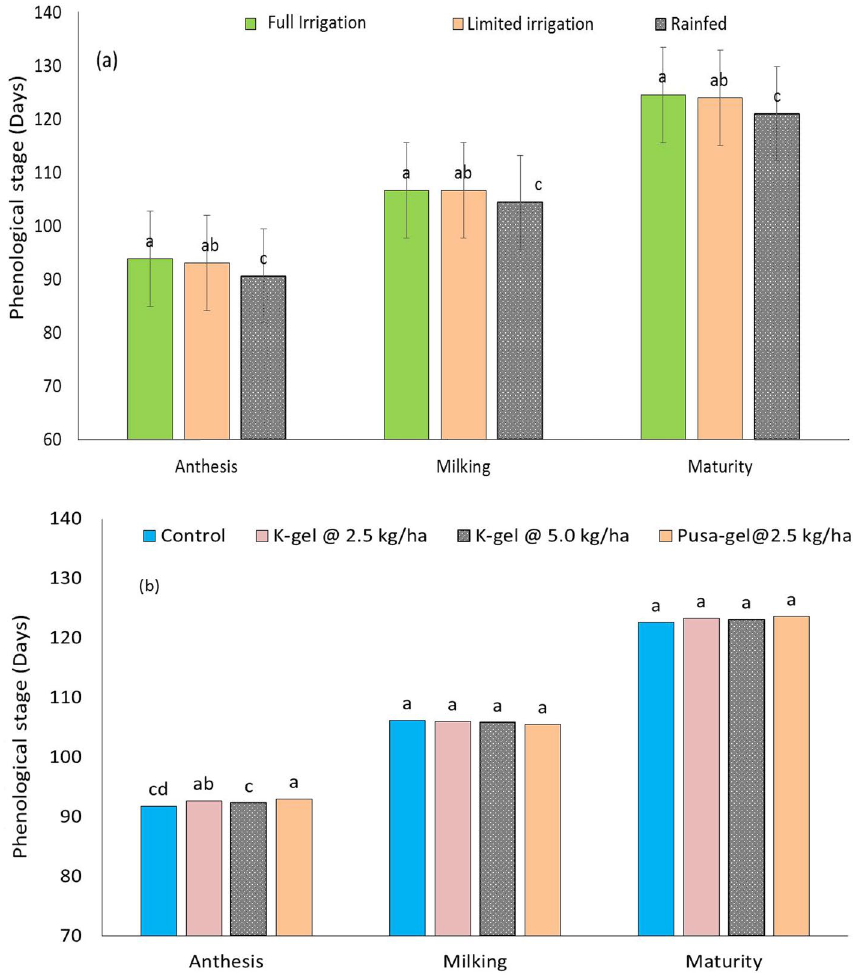
Figure 1. Effect of irrigation regimes ( a ) and hydrogels ( b ) on phenology of wheat. Bars indicate standard error of mean.